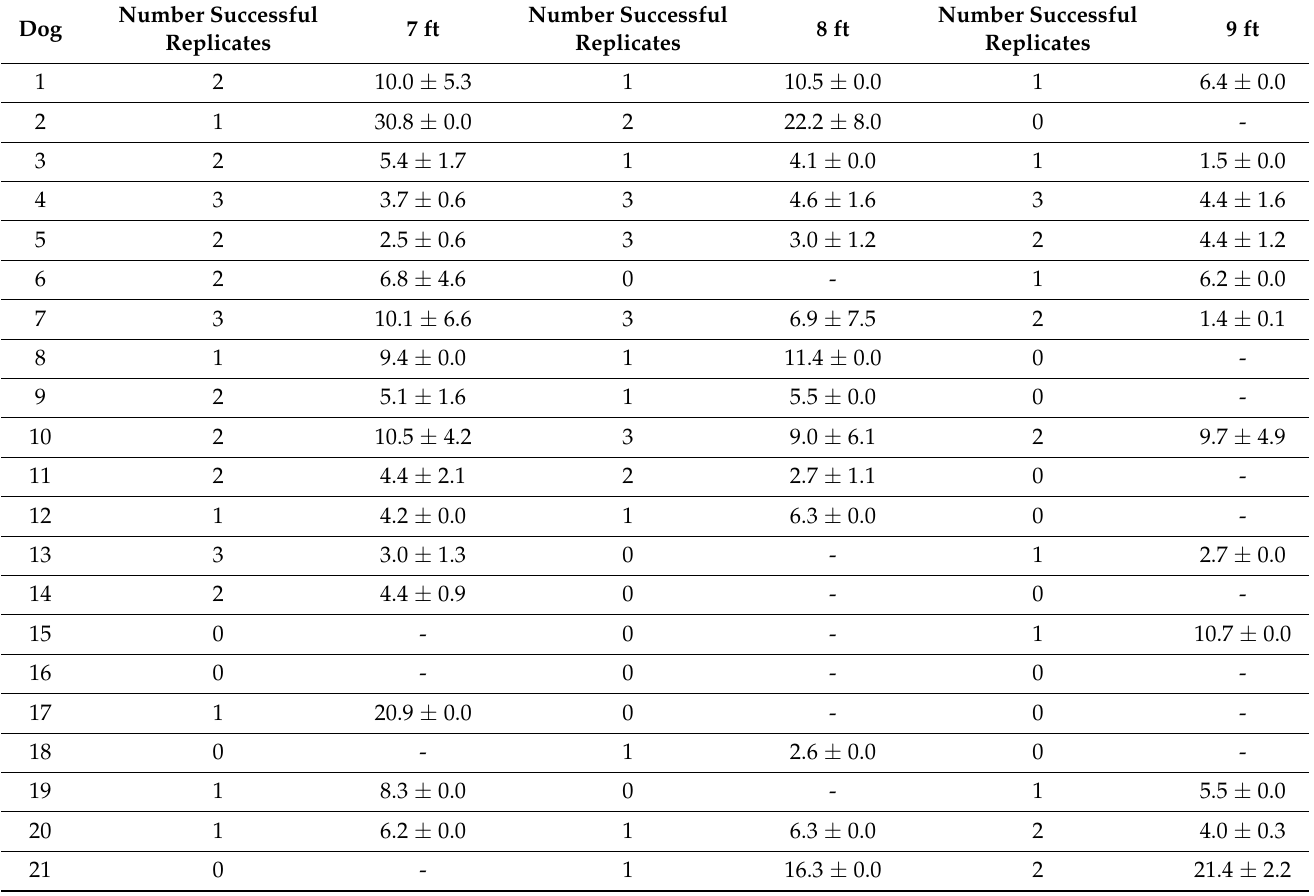
Table 2. Mean difference ( ± SD) between peak vertical landing force on dogs two front feet. PVF was only calculated when both feet successfully landed on the mat (and recorded maximum landing force on Tekscan mat). Number Dog